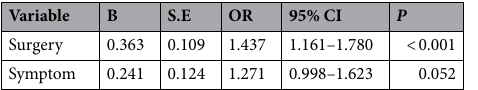
Table 5. The multivariate regression